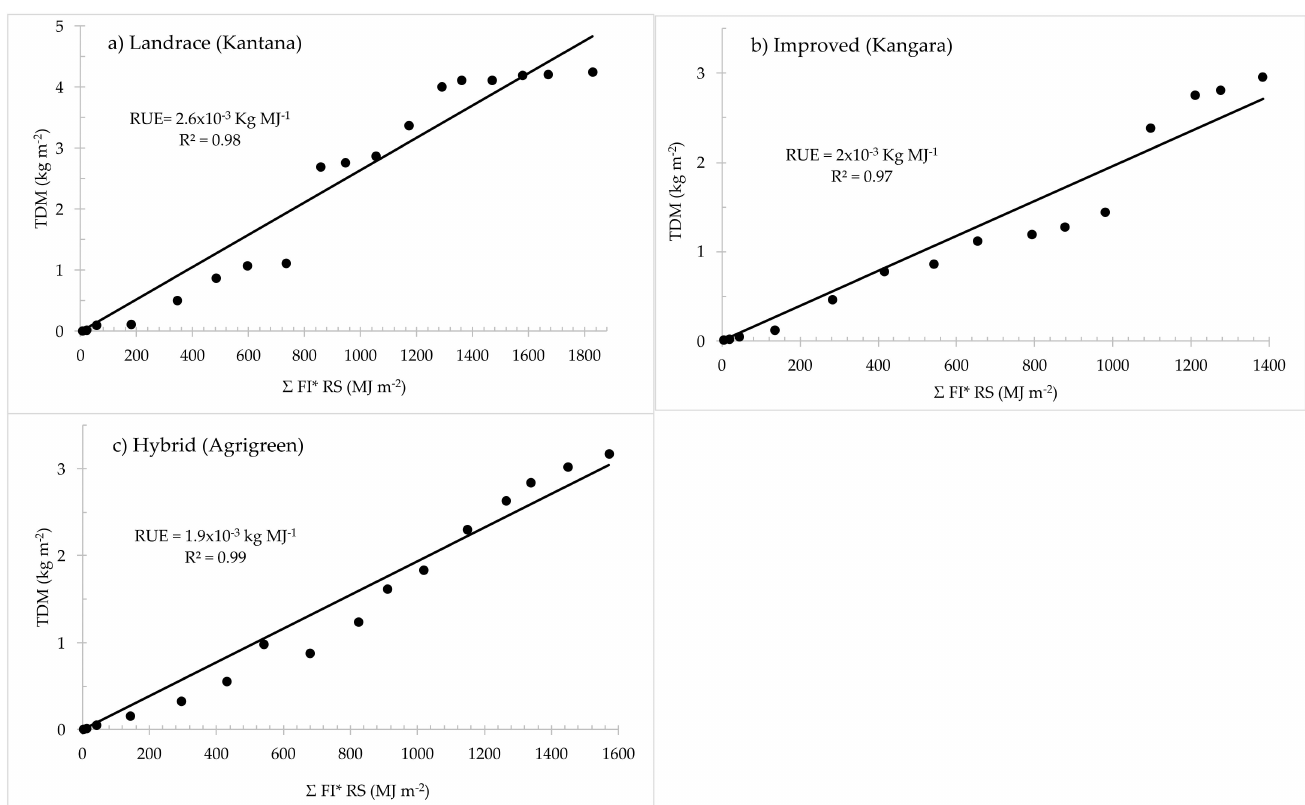
Figure 1. Cumulative top dry matter (TDM) production of the three pearl millet varieties: ( a ) landrace, ( b ) improved and ( c ) hybrid as a function of the cumulative ( ∑ ) product of fractional interception and solar radiation (FI × Rs). Radiation use efficiency (RUE) and the coefficient of determination (R 2 ) are shown. FI values were determined on the day of